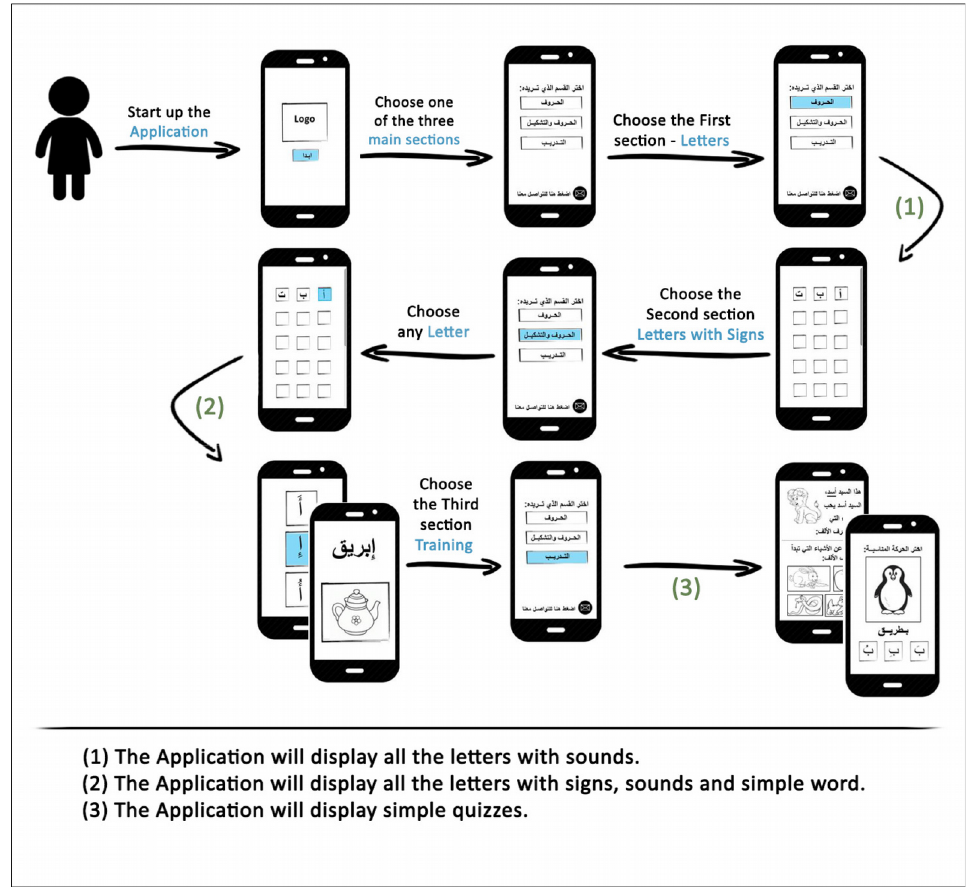
Figure 4. High-level architectural diagram of the Arabic Pronunciation